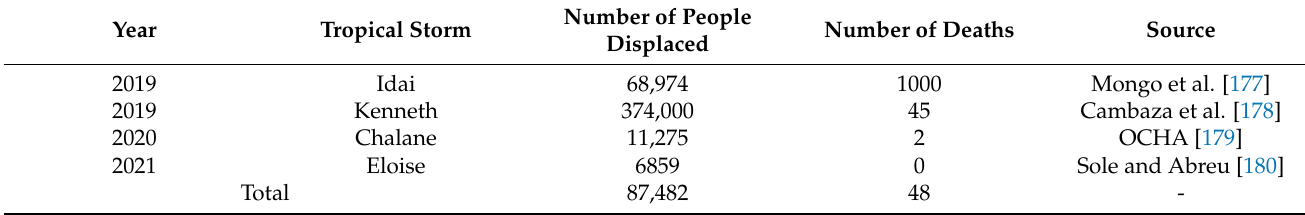
Table 2. Losses due to the recent tropical storms in